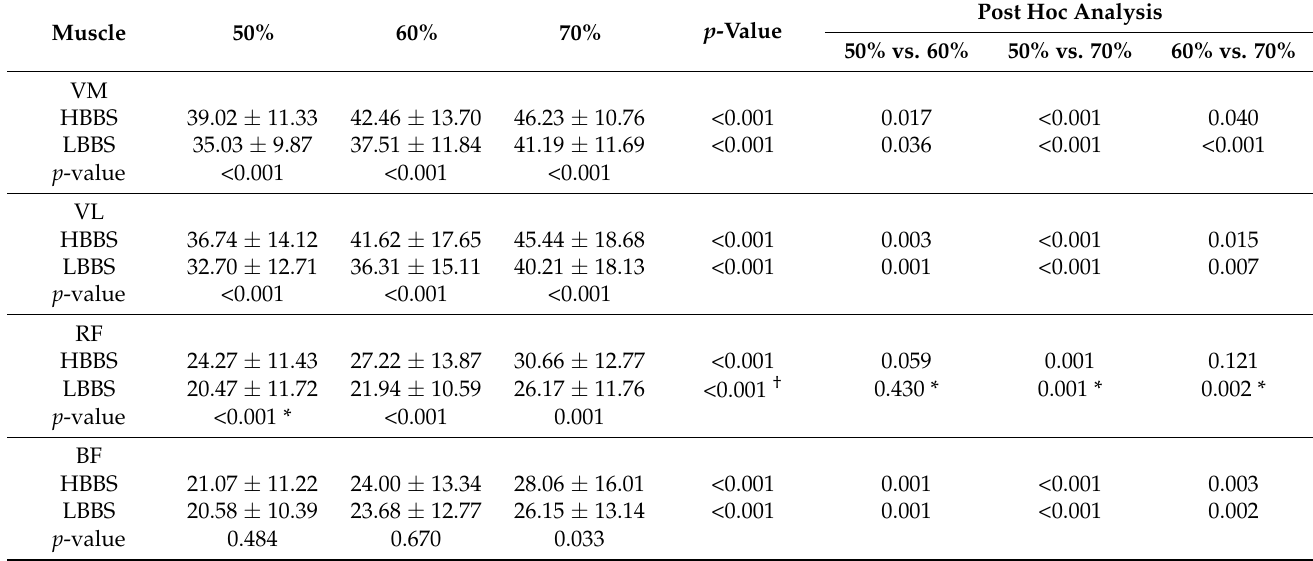
Table 3. Comparison of the muscle activity of the lower extremity during the concentric phase.